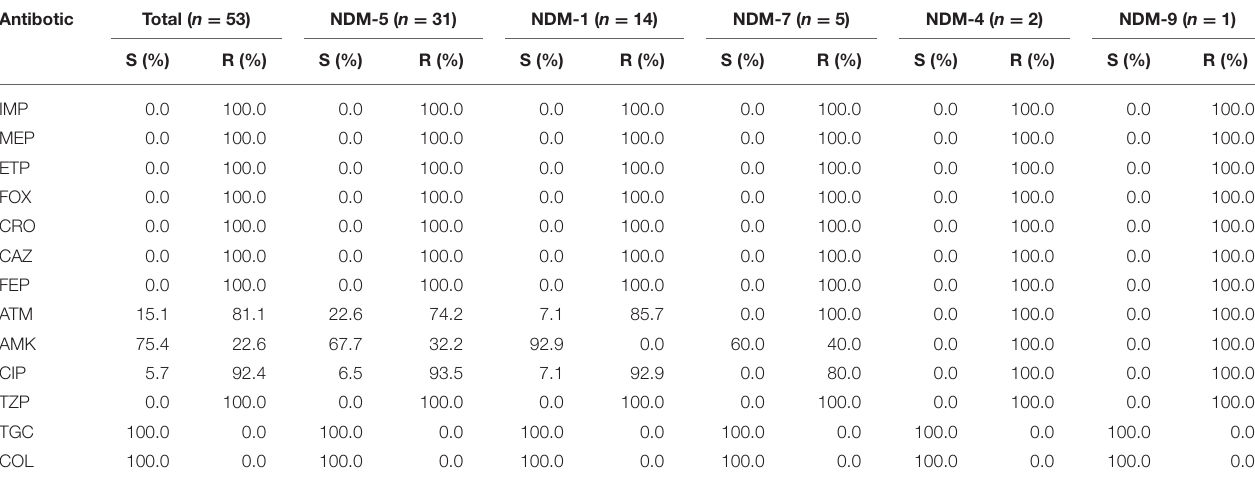
TABLE 2 | Antimicrobial susceptible patterns of NDM-producing Escherichia coli . Antibotic